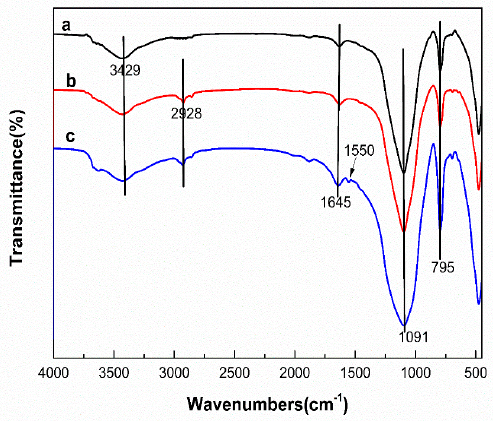
Figure 1. FTIR spectra of ( a ) silica clay (SC), ( b ) 3-aminopropyltriethoxysilane (APTES)-modified SC (A-SC) and ( c ) Lip–Glu–A-SC.